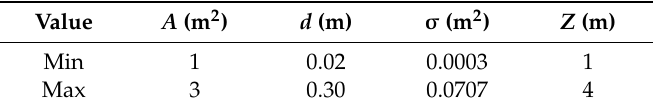
Table 1. Minimum (Min) and maximum (Max) values of the geometric. parameters assumed for the water tank.